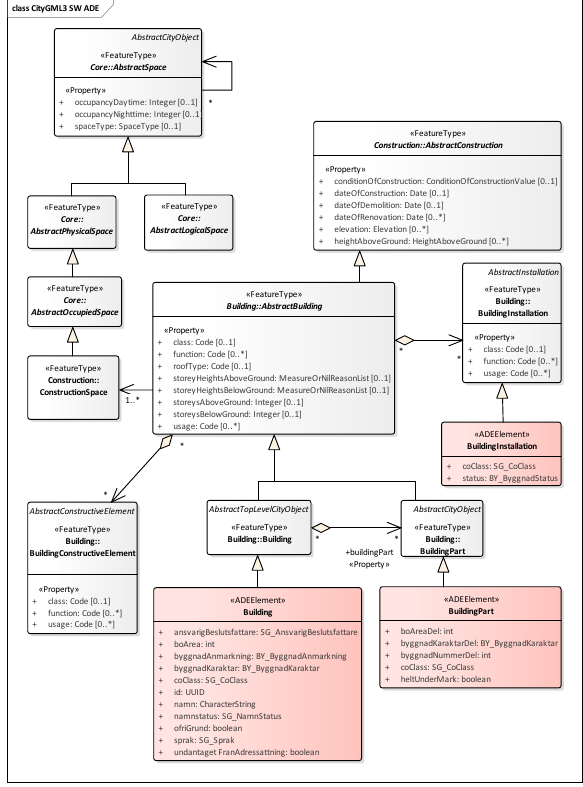
Figure 4. Draft proposal for a Swedish CityGML ADE (red classes are the